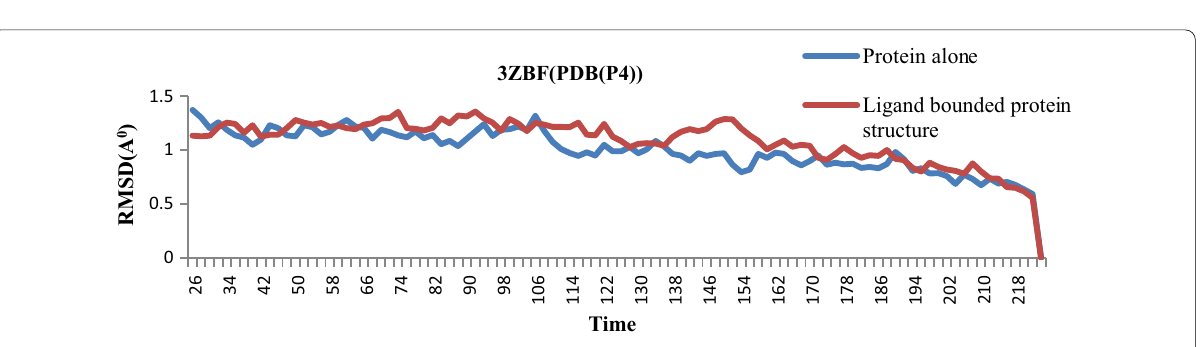
Fig. 4 RMSD graph of ligand-free protein and ligand bounded protein complex of C-ROS1 protein